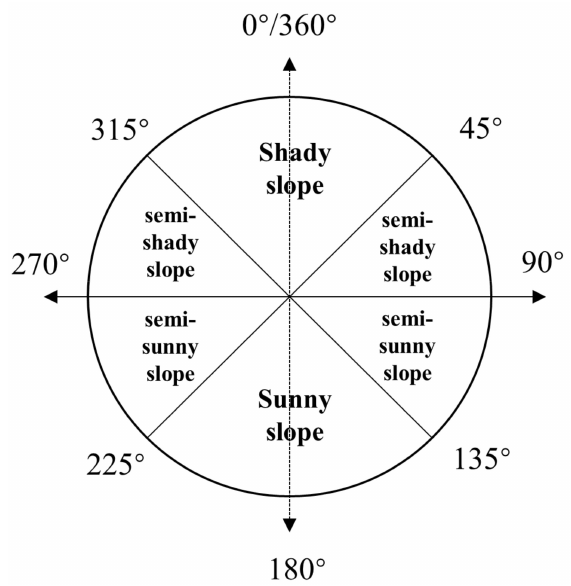
Figure 9. The diagram of aspect